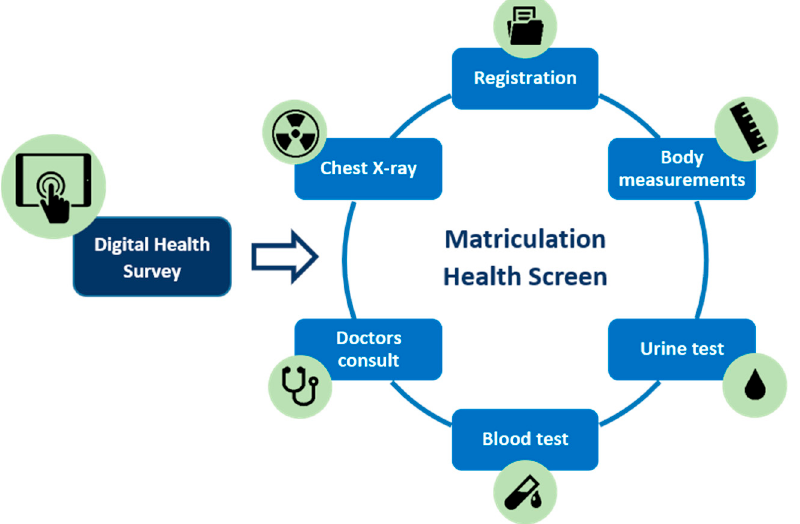
Figure 1. Matriculation health screen workflow.